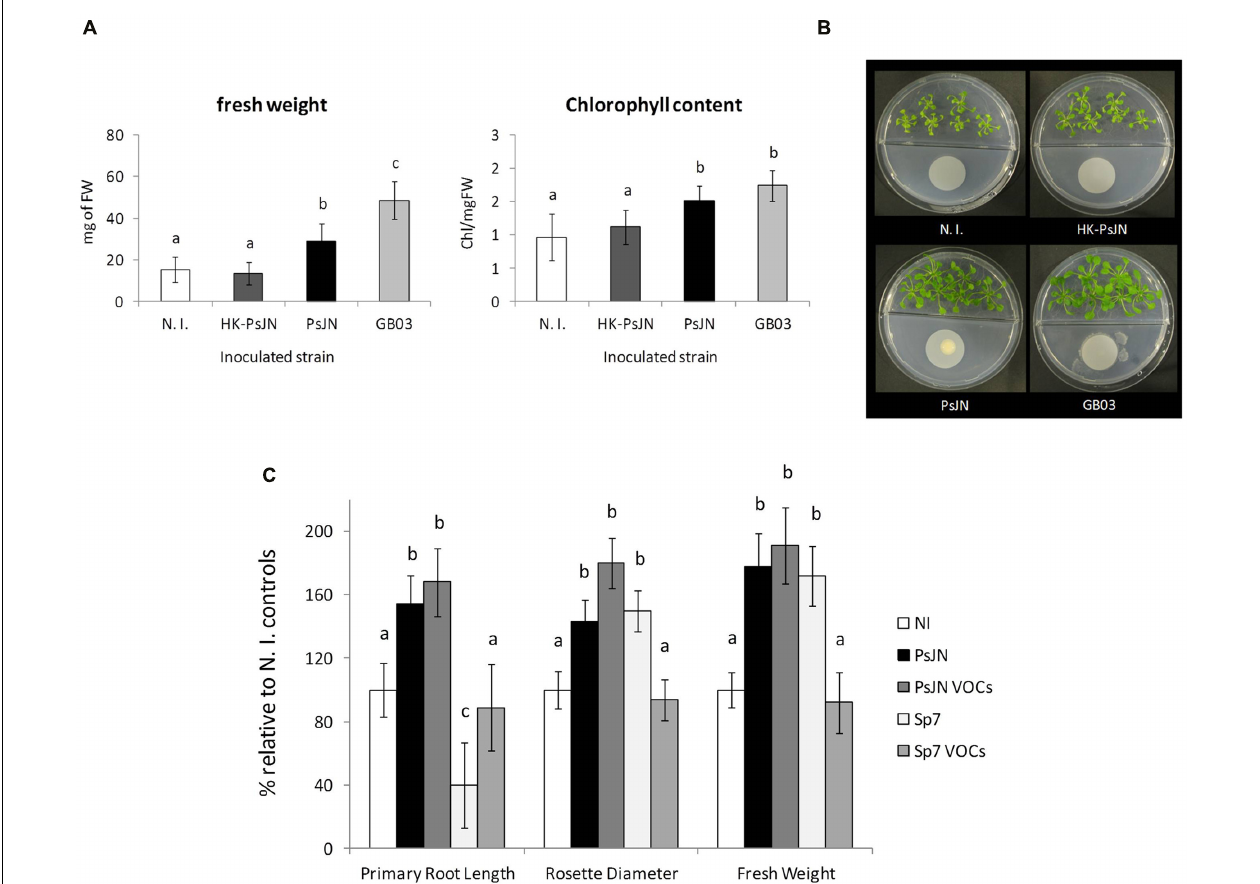
FIGURE 2 | Bacterial stimulation of A. thaliana growth mediated by volatile organic compounds (VOC) from P. phytofirmans PsJN. The effects of bacterial emission of volatile compounds was tested using divided petri dishes with A. thaliana col-0 plants sown in half strength MS medium agar on one side, and minimal medium for bacterial growth on the other. 1 × 10 6 CFU of the corresponding bacterial inoculum (N. I.; PsJN; HK-PsJN; or Bacillus sp. strain GB03) was added on top of a 0.022 µ m filter. Total fresh weight and chlorophyll content per mg of fresh tissue were measured at 21 DAS. Columns show mean values, while error bars indicate standard deviations for 30 plants (fresh weight) or 6 plants (chlorophyll content) ( A , left and center panels). Different letters indicate statistically significant differences among bacterial treatments (One-way ANOVA, p < 0.05). Representative photographs of plates are presented for each bacteria treatment (B) . Root growth, rosette diameter and fresh weight of A. thaliana (C) directly inoculated with 1 × 10 4 CFU/ml of strain PsJN (PsJN), 1 × 10 4 CFU/ml of A. brasilense strain Sp7 (Sp7), or co-incubated separately with each of these strains in dual plate systems (PsJN VOCs or Sp7 VOCs, respectively). Growth parameters were registered at 21 DAS. Bars show mean percentage values relative to N. I. plants, and the error bars indicate standard deviations from experiments with 24 plants analyzed for each bacterium and salt treatment. Different letters indicate statistically significant differences among bacterial treatments within each salt concentration for each measured parameter (One way ANOVA Tukey’s HSD tests; p <